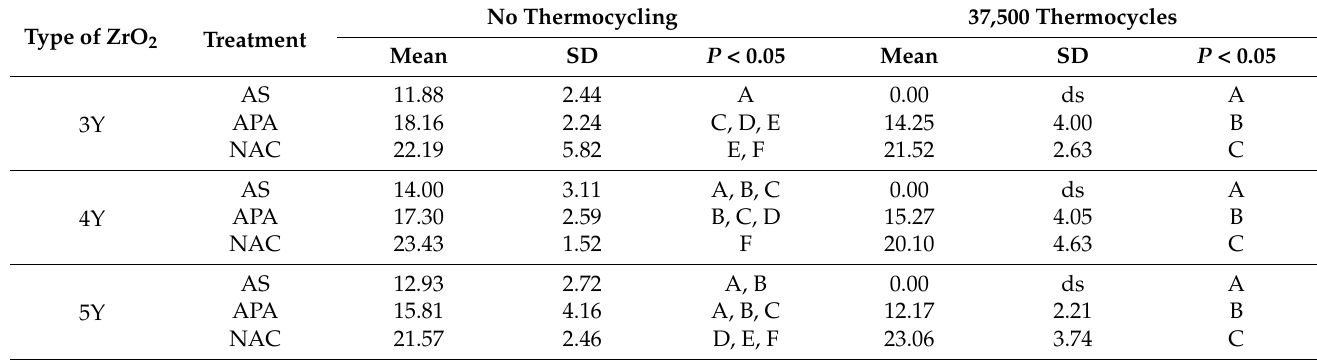
Table 1. Shear bond strength (SBS) means and standard deviations (SD) in MPa of resin cement to the three types of zirconia ceramics after different surface pretreatment methods. Same upper-case letters denote no statistical differences in SBS values among the groups ( P < 0.05).